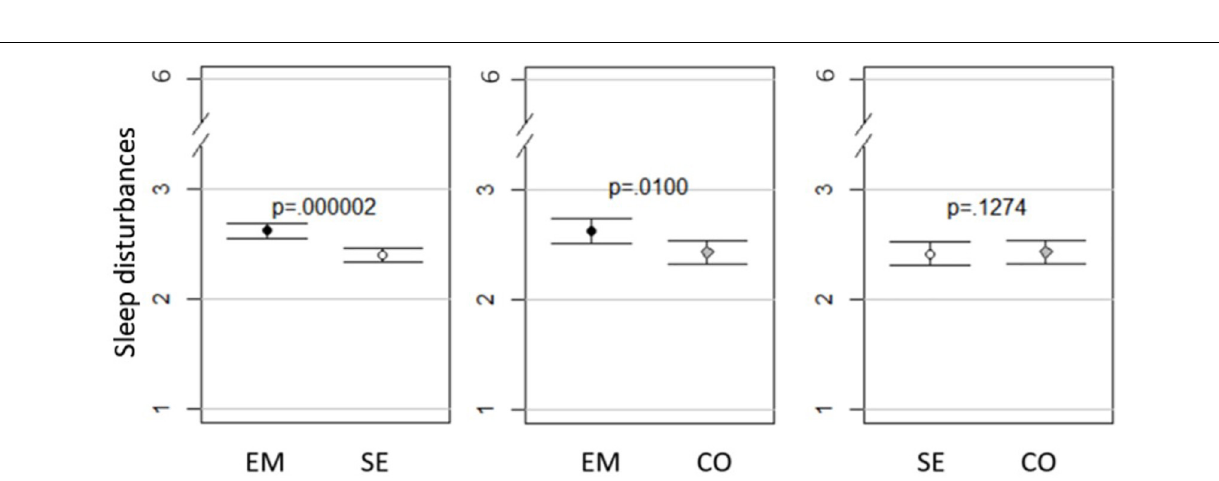
FIGURE 2 | Mean emotional exhaustion with 95% Cl and p -values in employed (EM), self-employed workers (SE), and combinators (CO).